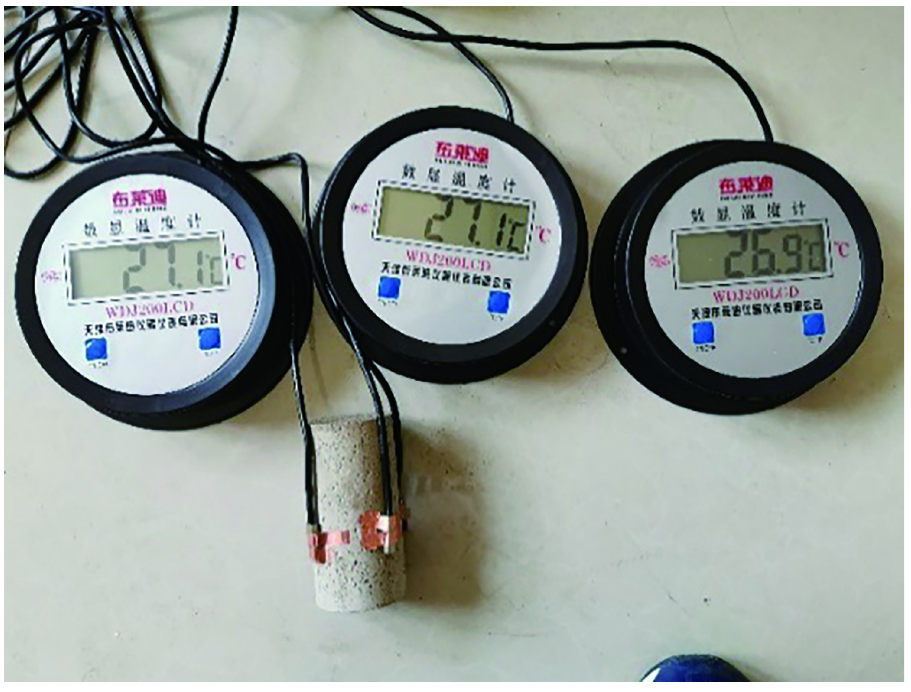
Fig 14. Specimen temperature measuring